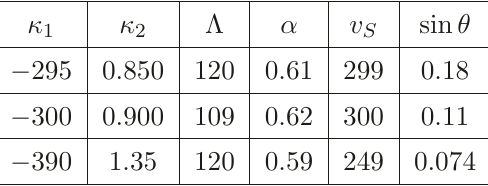
Table 2 . Lagrangian parameters for the four benchmarks for SM+S as well as the mixing angle sin θ . Higgs sector parameters are determined by fixing the mass of the Higgs and W boson. All dimensionful parameters are given in